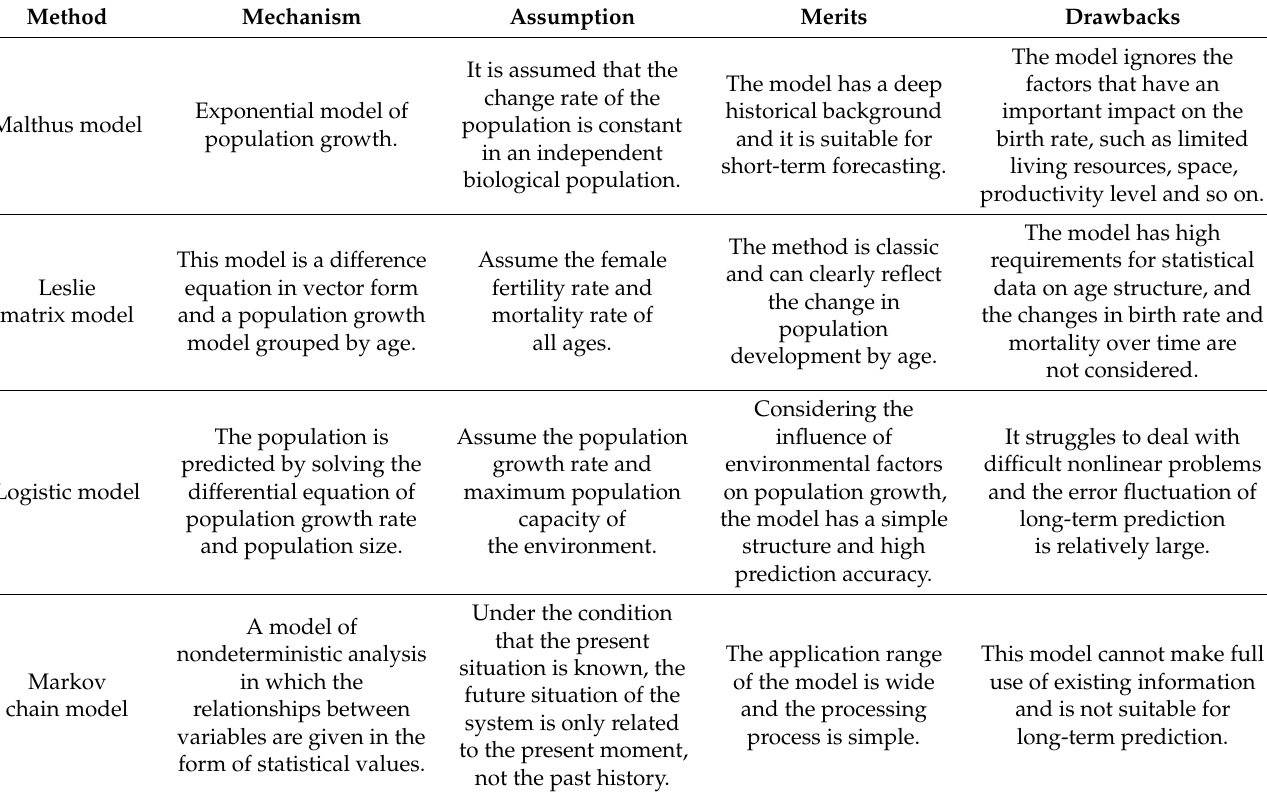
Table 1. Summary of mainstream population prediction